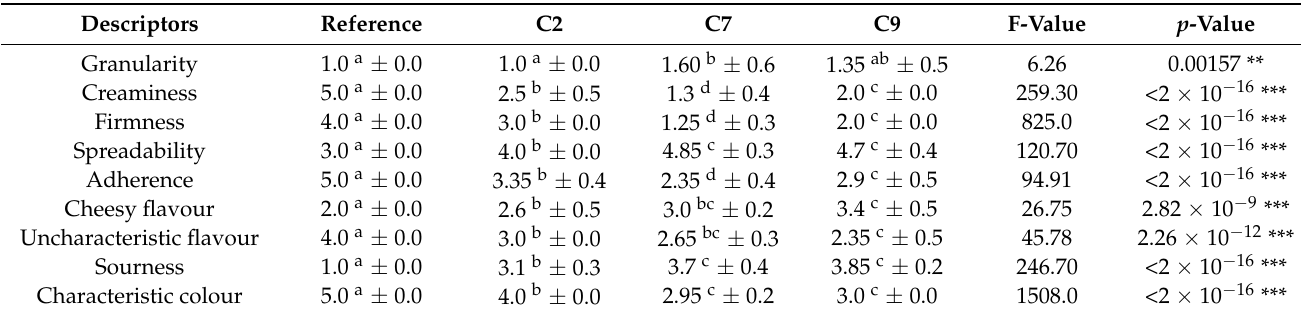
Table 7. Sensory characterisation of the spreadable cheese analogues. Values are shown as means ± standard deviations. F-values and p -values for the product from one-way ANOVA on all descriptors are also